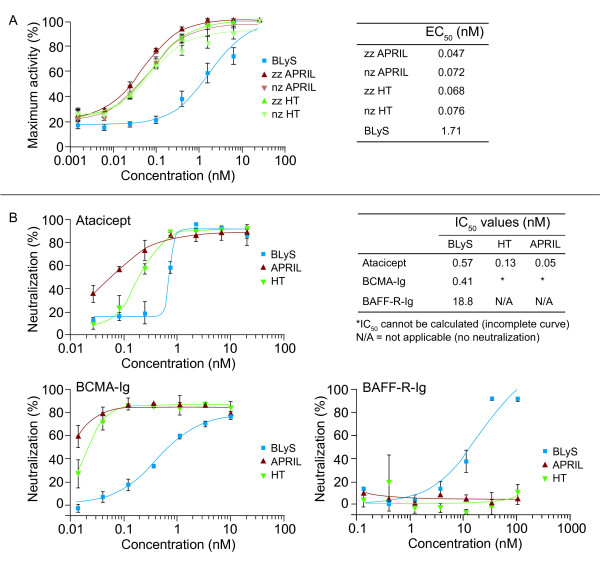
(a) Biologic activity and (b) neutralization of BLyS/APRIL HTs compared with those of BLyS and APRIL in TACI-Jurkat proliferation assays. APRIL, a proliferation-inducing ligand; BAFF-R, BAFF receptor; BCMA, B cell-maturation antigen; BLyS, B-lymphocyte stimulator; EC50, 50% effective concentration; HT, heterotrimer; IC50, 50% inhibition concentration; Ig, immunoglobulin; nz, trypsinized trimer without the "zipper" domain; TACI, transmembrane activator and CAML interactor; zz, trimer containing the "zipper" trimerization domain.